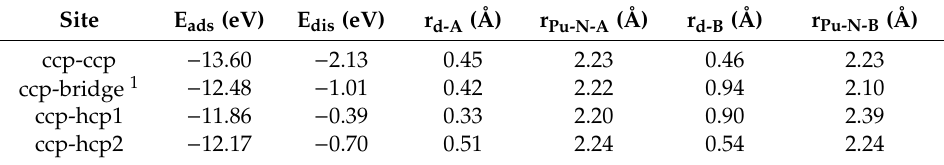
Table 3. Adsorption and dissociative adsorption energies of the possible dissociative adsorptions of nitrogen onto PuH 2 (111) surface. Adsorption parameter r d is the vertical distances from the surface and r Pu-N is the average distances of Pu-N. The subscript A denotes the ccp site atom, and B denotes the